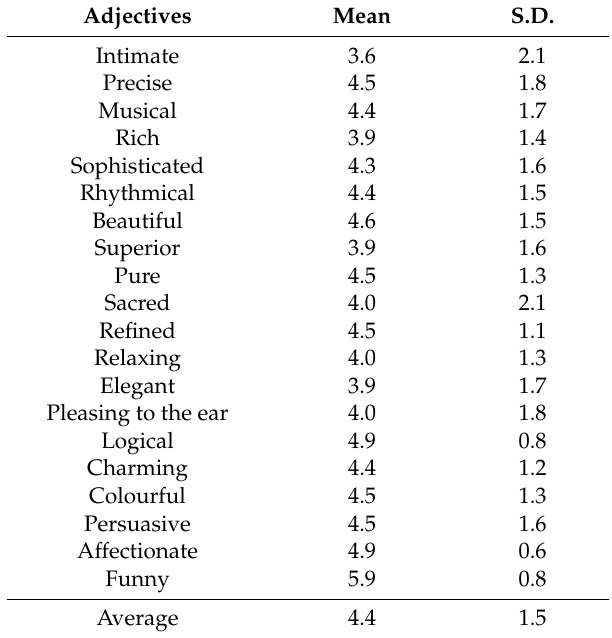
Table 4. Semantic Differential Ratings of Equatoguinean